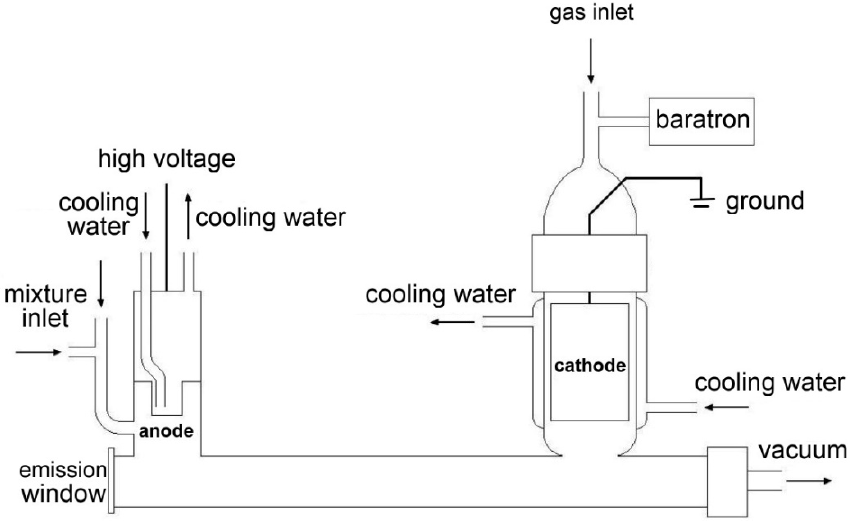
Figure 1. Scheme of the discharge cell.